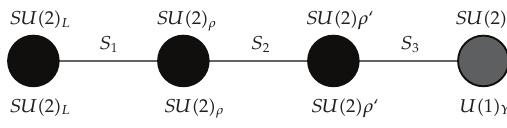
Figure 4: Diagram of the 4-sites